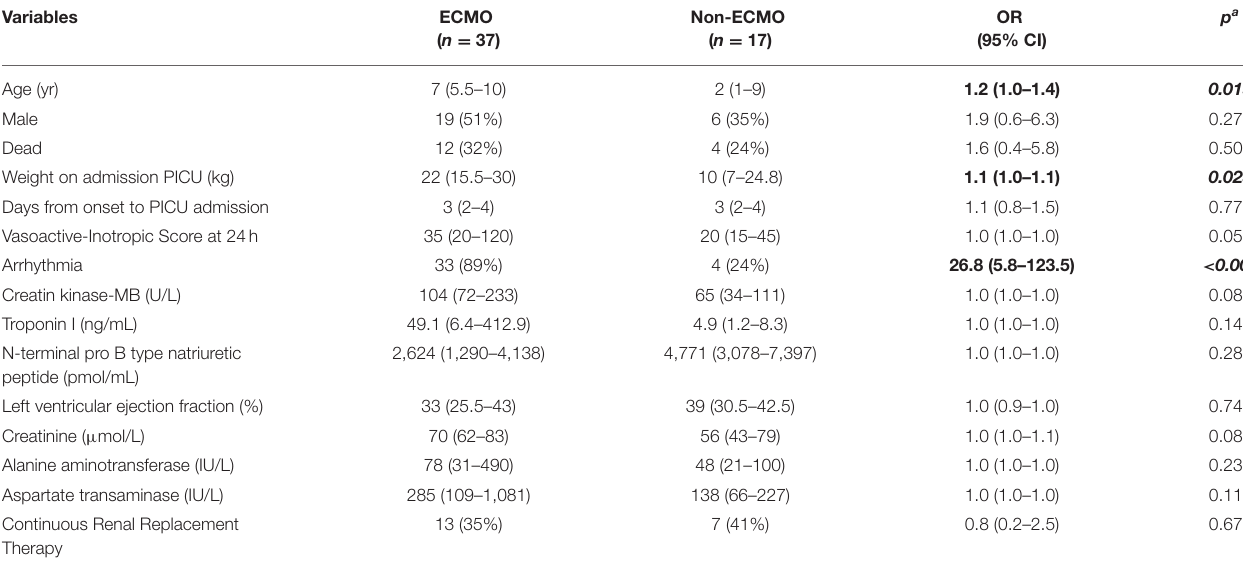
TABLE 3 | Comparison of factors between patients with and without extracorporeal membrane oxygenation.